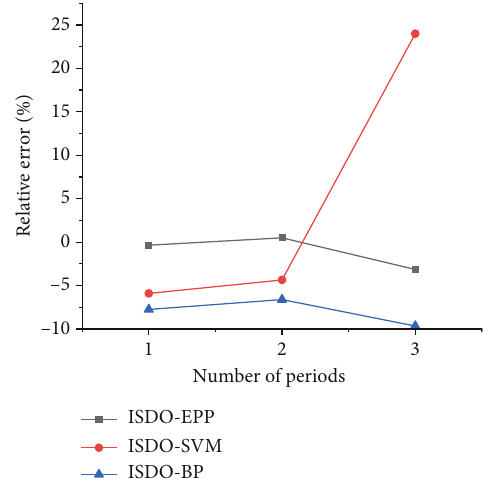
Figure 7: Relative error of three models in example